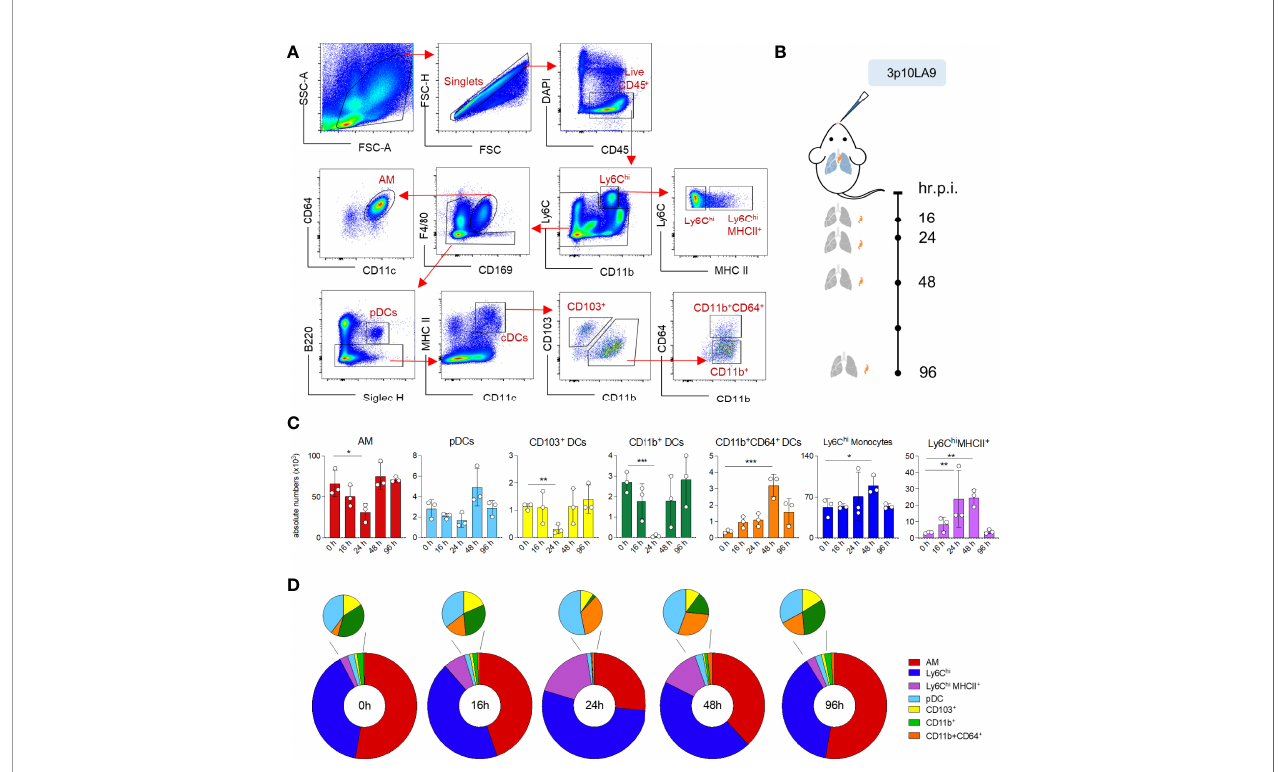
FIGURE 4 | Impact of intranasal dsRNA hairpin treatment on the pulmonary myeloid cell landscape. (A) Representative fl ow cytometry dot plots showing the gating strategy for the myeloid cell landscape in lungs of 8-week-old C57BL/6J mice. AM: F4/80 hi CD169 + ; monocytes: CD11b + Ly6C high MHCII - ; MHCII + monocyte: CD11b + Ly6C high MHCII + ; pDCs: B220 + Siglec-H + ; cDCs: CD11c hi MHCII + ; CD103 + cDC1s: CD103 + CD11b - ; CD11b + cDC2s: CD103 - CD11b + CD64 - ; CD11b + CD64 + cDCs: CD103 - CD11b + CD64 + . (B) Intranasal treatment protocol and time points of lung collection. (C) Absolute numbers of pulmonary AM, pDCs, CD103 + DCs, CD11b + DCs, CD11b + CD64 + DCs, Ly6C hi monocytes and Ly6C hi MHCII + monocytes at 0h, 16h, 24h, 48h and 96 h post inoculation. The error bars represent the SEM (n= 3 mice). * P <0.05; ** P <0.01; *** P <0.001; two-tailed t-Student ’ s Test. (D) Donut chart showing distribution of the absolute numbers of AM, DC subpopulations and monocytes following 0, 16, 24, 48 and 96 h post intranasal delivery. Values are shown in panel (C)